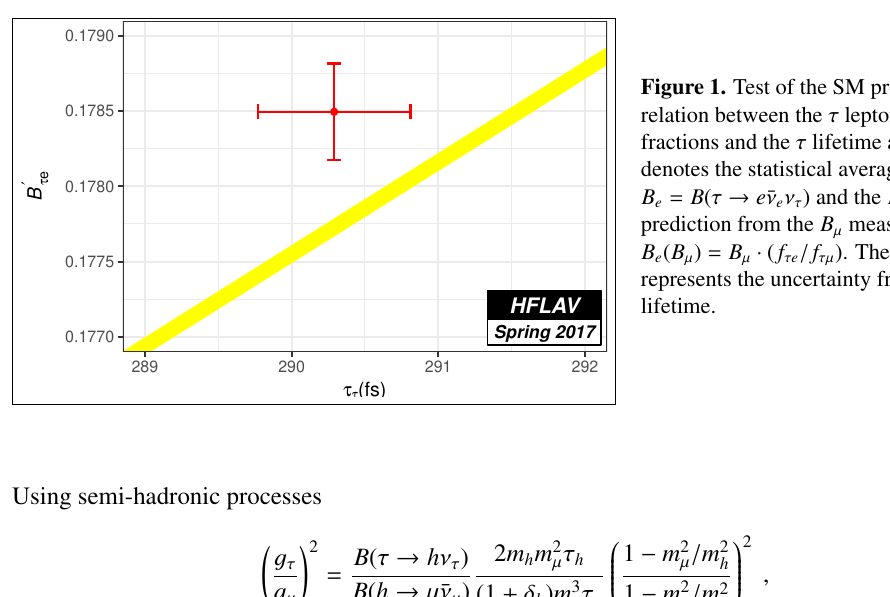
Figure 1. Test of the SM prediction of the relation between the τ leptonic branching fractions and the τ lifetime and mass. B ′ denotes the statistical average of B e = B ( τ e ¯ ν e ν τ ) and the B e SM → prediction from the B µ measurement B e ( B µ ) = B µ ( f τ e / f τµ ). The yellow band · represents the uncertainty from the τ